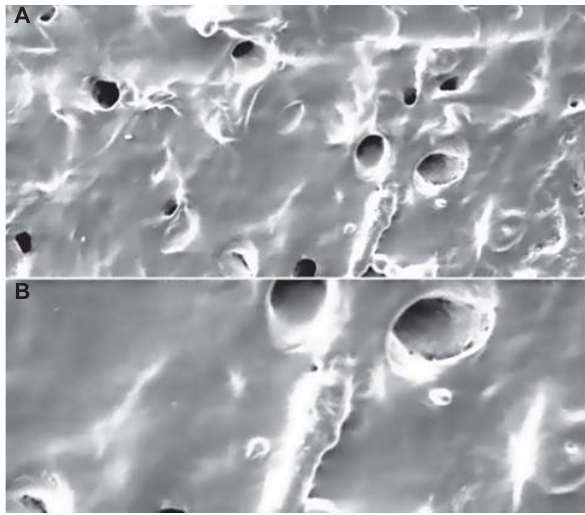
FIGURE 1A and B- Scanning electron microscopy of a soft denture reliner showing the extents of defect; it is notable to observe that the material not only exhibits porosities, but also show surface irregularities, which may turn into